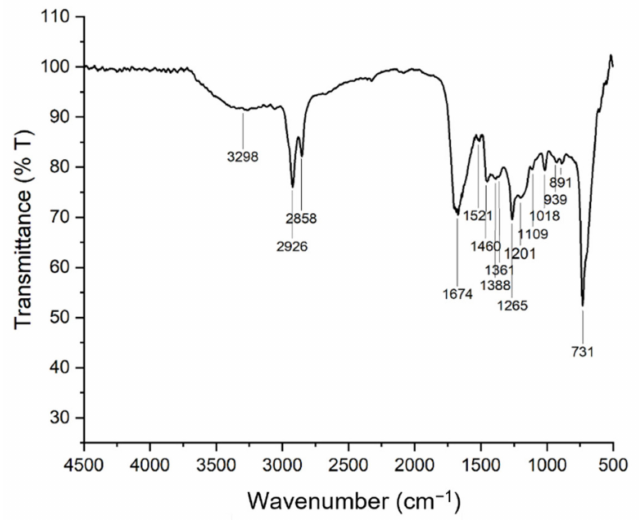
Figure 10. FTIR spectrum of the HTL bio-oil